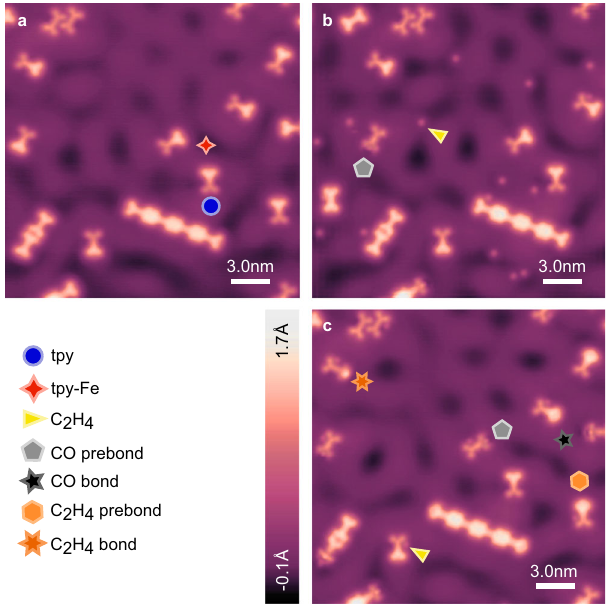
Fig. 2 | STM overviews of reaction progression. STM topographs of the same region of a sample imaged after active Fe-tpy site preparation ( a ), after subsequent exposuretoCOandC 2 H 4 (maximumtemperatureduringdosing11.1K)( b ),andafter successive incremental sample annealing up to T =30K for t =5min ( c ). Free C 2 H 4 (yellow triangle) is visible on the surface, along with changes to active sites labelled “ COprebond ” (greypentagon),aftergasexposure( b ).Aftersubsequentannealingof thesampleat T =30Kfor t =5min( c )threeadditionaldistinctchangestoactivetpy- Fe sites are visible and labelled: “ CO bond ” (black fi ve point star), “ C 2 H 4 prebond ” (light orange hexagon), and “ C 2 H 4 bond ” (orange six point star). After the anneal, C 2 H 4 moleculescanformpseudohydrogenbondswiththenitrogenlonepairsofthe distal, outward pointing pyridyl of non-metalated tpy groups ( c , yellow triangle). Images shown were acquired with a metal tip at V =20mV and I =20pA ( a – c ).